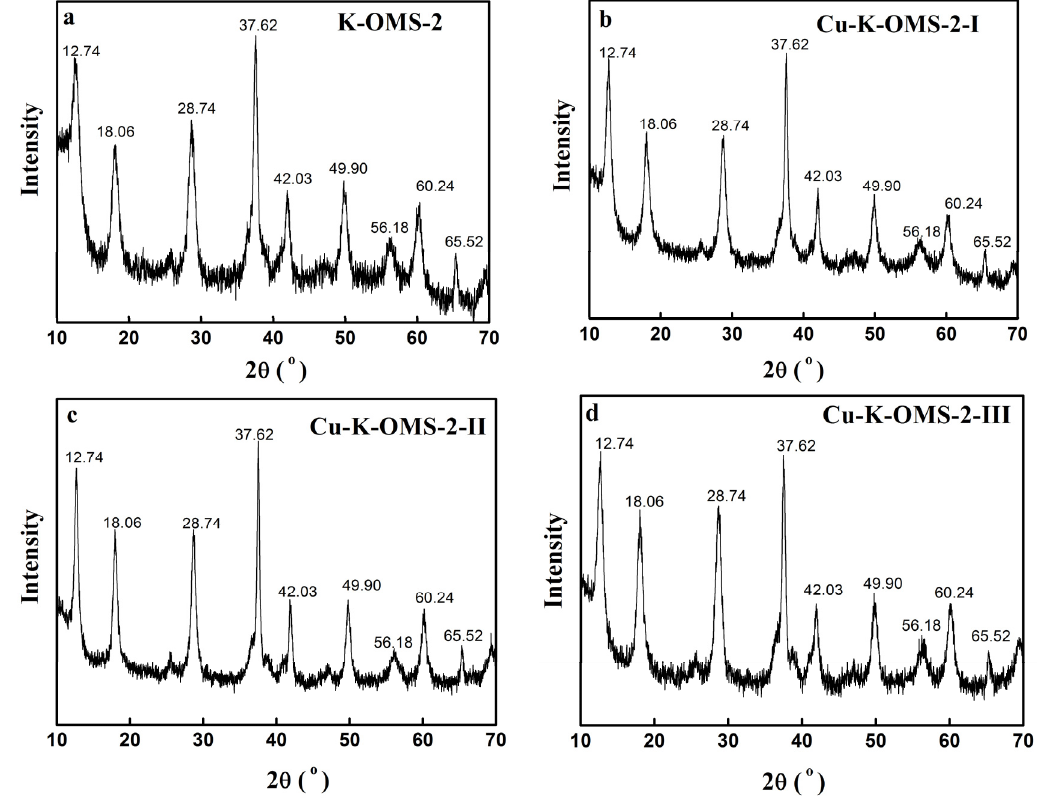
Figure 3. XRD patterns for K-OMS-2 ( a ), Cu-K-OMS-2-I ( b ), Cu-K-OMS-2-II ( c ), and Cu-K-OMS-2-III ( d ).